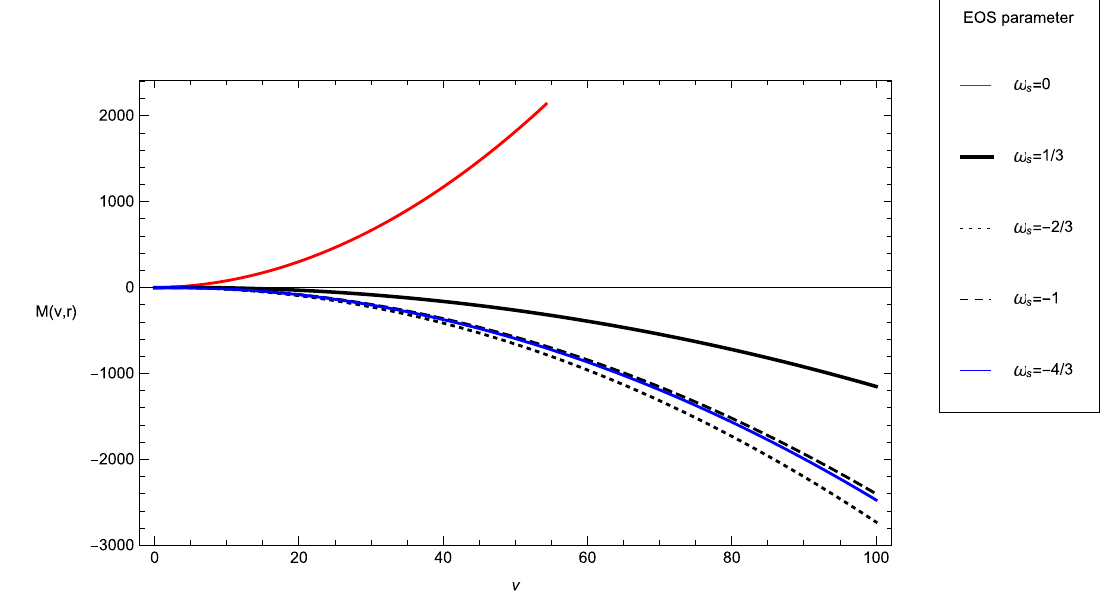
Fig. 1 Plot indicating the temporal evolution of the mass function with respect to each of the matter field parameters